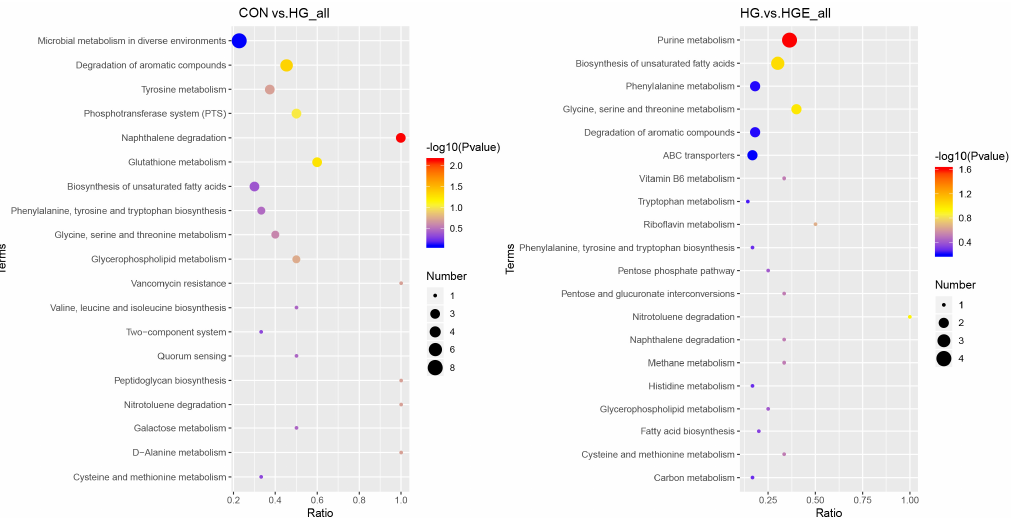
Figure 2. Functional annotation of differential metabolites. ( left ) CON-HG, ( right ) HG-HGE.